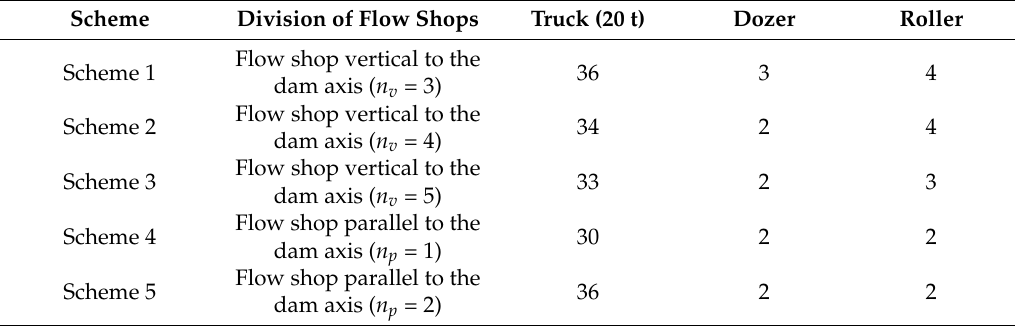
Table 2. Flow shop construction schemes in the core wall at Elevation 2740 m to Elevation 2759 m.